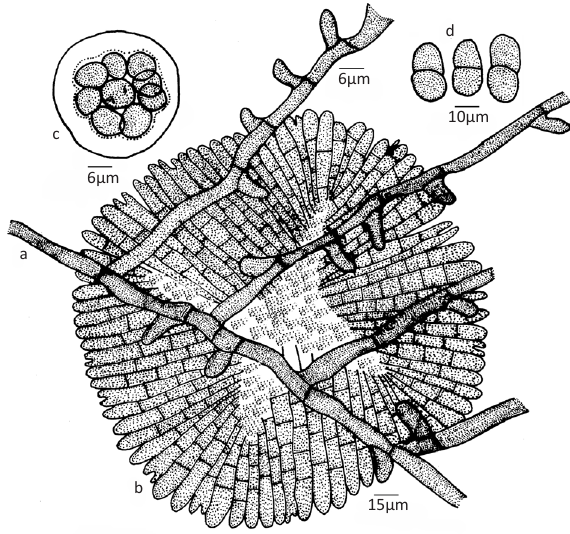
Figure 1. Asterina drypetigena sp. nov. a - Appressoriate mycelium; b - Thyriothecium; c - Ascus; d -